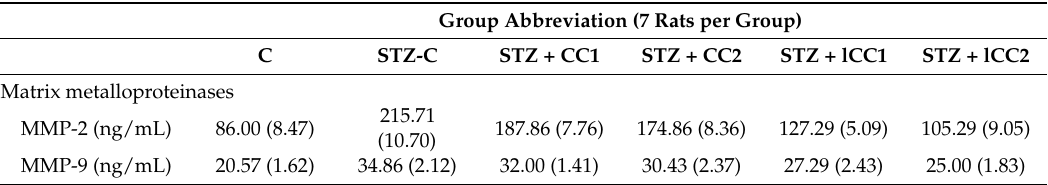
Group Abbreviation (7 Rats per Group)